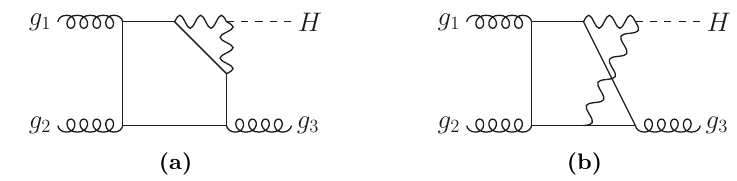
Figure 1. Representative planar (a) and non-planar (b) Feynman diagrams for the LO mixed QCD-EW corrections to gg → Hg . The internal wavy lines represent the massive vector bosons.